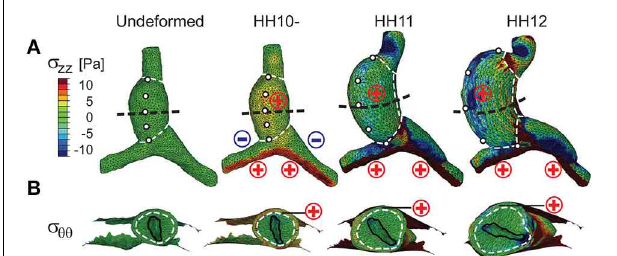
FIGURE 4 | Stress distributions in baseline model for c-looping. (A) Longitudinal stress ( σ zz ) and (B) circumferential stress ( σ θθ ) are shown at three looping stages in ventral and transverse cross-sectional views [black dashed lines in (A) ], respectively. To help visualize the deformation, white dashed lines divide the heart into regions, and artificial markers along the ventral midline of the undeformed heart tube (HT) indicate rotation. For comparison, “ ⊕ ” (red) and “ (cid:8) ” (blue) signs denote regional myocardial tension and compression for the corresponding stress component, as previously revealed by microsurgery experiments (Voronov et al., 2004; Zamir and Taber, 2004; Shi et al., 2014). Note the rightward rotation of the HT as shown by the motion of the markers in (A) and the lumen orientation in (B) . Scale and legend are the same in (A,B)